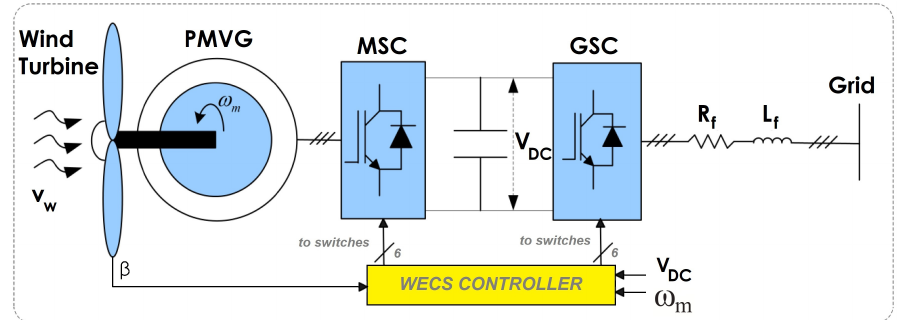
Figure 1. System configuration of WECS based on